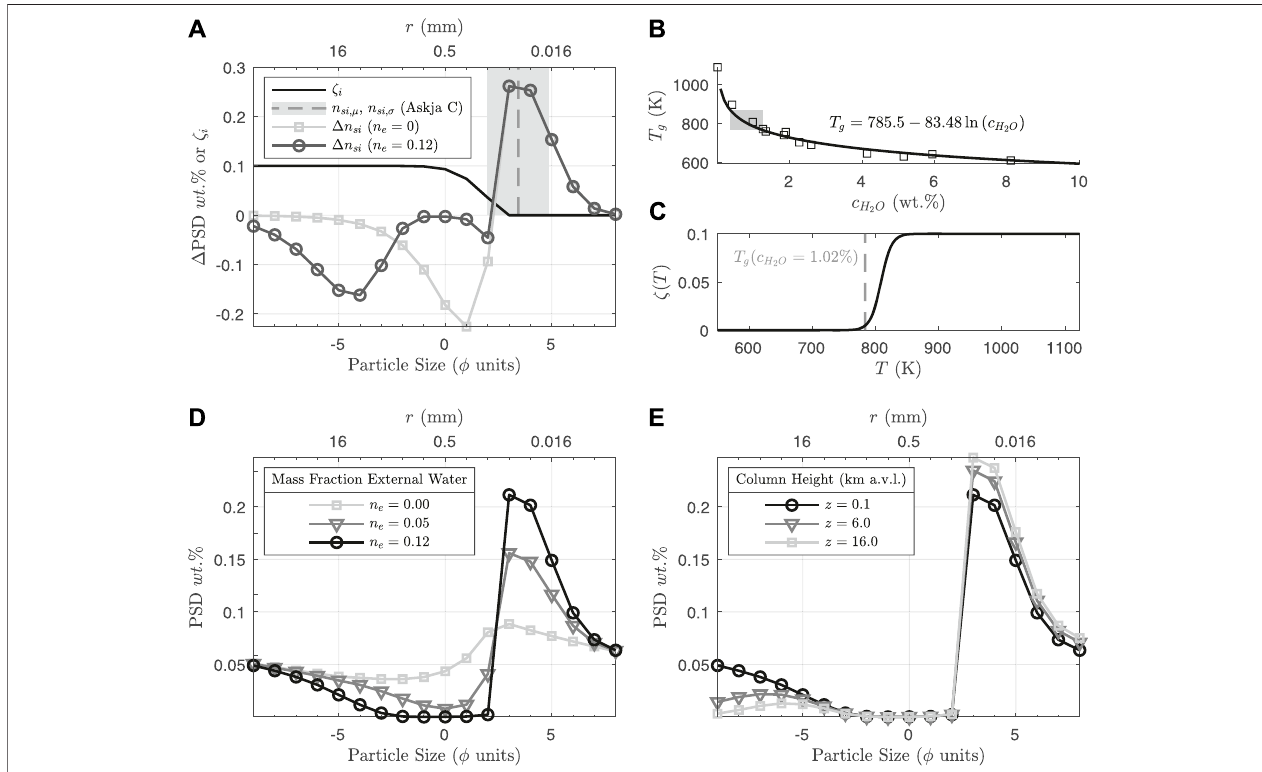
FIGURE3| PSDandquenchfragmentationmodelforrhyoliticmelt,usingasingleexamplesimulationwith q =1.03×10 8 kg/s, Z e =120m,and ζ =0.1. (A) Change inPSD( Δ n s , i = − n si ,0 + n si , f )from Eq.52 attwodifferentmassfractions ofentrained externalwater n e .The “ output ” particle sizesofquenchfragmentation n si , f arede fi ned from the mean and standard deviation (in ϕ units, shown as the vertical grey dashed line and shaded region, respectively) of the Askja phase C deposit, as reported in Costa et al. (2016). The “ input ” particle sizes − n si ,0 (i.e., from which mass is removed to generate the products of quench fragmentation), are a function of available surface area in the PSD coarse fraction ( Equation 49 ), and evolve as the total PSD coarse fraction is progressively depleted with increasing n e (see also panel (D) ). The solid black line shows ζ i ( Equation 47 ), which de fi nes the size bins for the “ coarse ” fraction. (B) Glass transition temperature T g data from Dingwell (1998) (squares) and curve fi t(black line)asafunctionofconcentrationofdissolvedwaterin themelt.Thegrey shaded rectangle showstherange ofvaluesinthe Reference set ofsimulations after exit from the vent. (C) Fragmentation energy ef fi ciency as a function of temperature ( Equations 45 , 46 ) for T g = 784 K. (D) Evolution of the total PSD n s , i during quench fragmentation. The initial power law PSD, with no external water, and therefore no quench fragmentation ( n e = 0), is shown in light grey, with a reduced mass fraction in the range ϕ ≲ 2 arising from the large porosity and consequentlylow density ofthese particles ( Eqs. 11 – 13 ). The remaining dark grey and black lines show n s , i after quench fragmentation for n e = 0.05 and n e = 0.12, respectively. After suf fi cient external water is entrained ( n e ≈ 0.12) to cross T g , n s , i does not evolve further from quenchfragmentation.Notethatowingtotheirlargersurfacearea,particlesarepreferentiallydepletedinthemid-size-range( − 3 ≲ ϕ ≲ 2). (E) Furtherevolutionof n s , i due to particle fallout, after water breach and during subaerial column rise, with preferential fallout of the coarsest fraction ( ϕ ≲ − 3) and additional enriching of fi